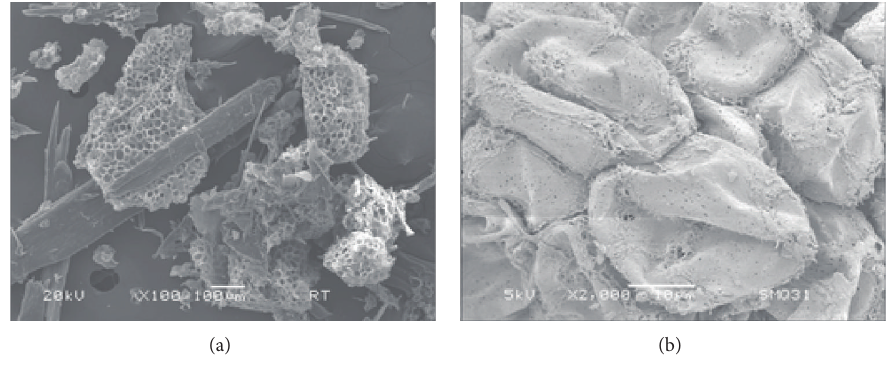
Figure 5: SEM micrographs of quill to 100x (a) and 2000x (b).